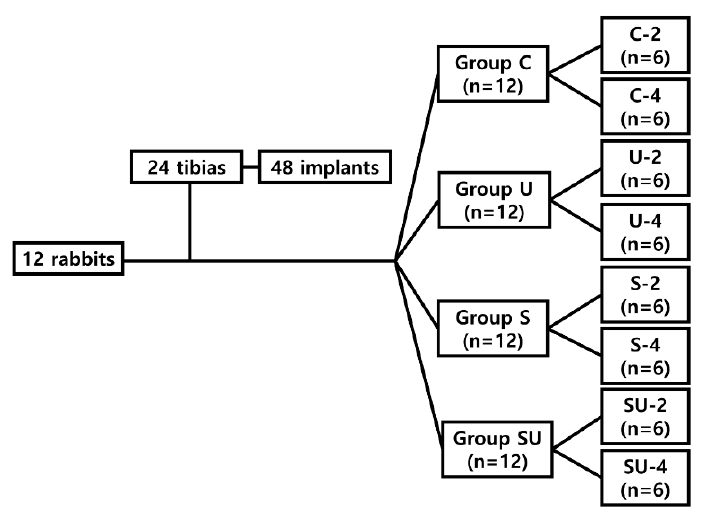
Figure 1. Flowchart of classification of the in vivo experimental groups. Group C, control group: implants without additional surface treatments in rabbits sacrificed at 2 weeks (C-2) or 4 weeks (C-4). Group U: implants irradiated with UV without immersion in SIM solution in rabbits sacrificed at 2 weeks (U-2) or 4 weeks (U-4). Group S: implants immersed in SIM solution for 24 h without UV exposure in rabbits sacrificed at 2 weeks (S-2) or 4 weeks (S-4). Group SU: implants first immersed in SIM solution for 24 h followed by UV irradiation before placement in rabbits sacrificed at 2 weeks (SU-2) or 4 weeks (SU-4). UV, ultraviolet; SIM, simvastatin.